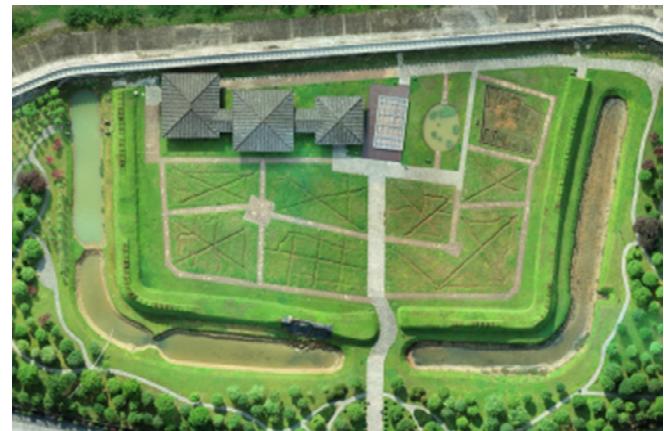
Figure 2. Present situation of the ruins.